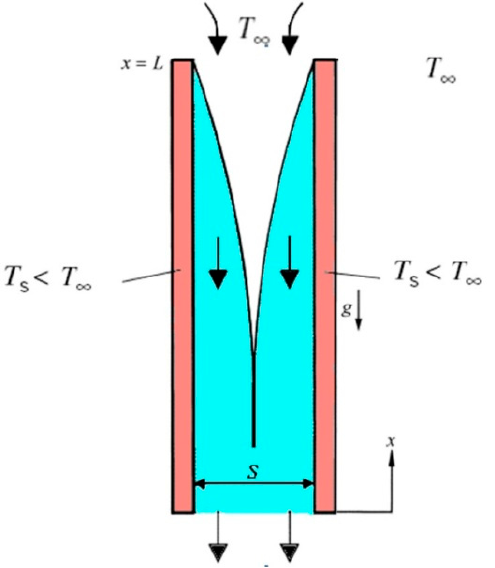
Figure 11. Development of marginal layers on the walls of parallel vertical plates in natural convection.